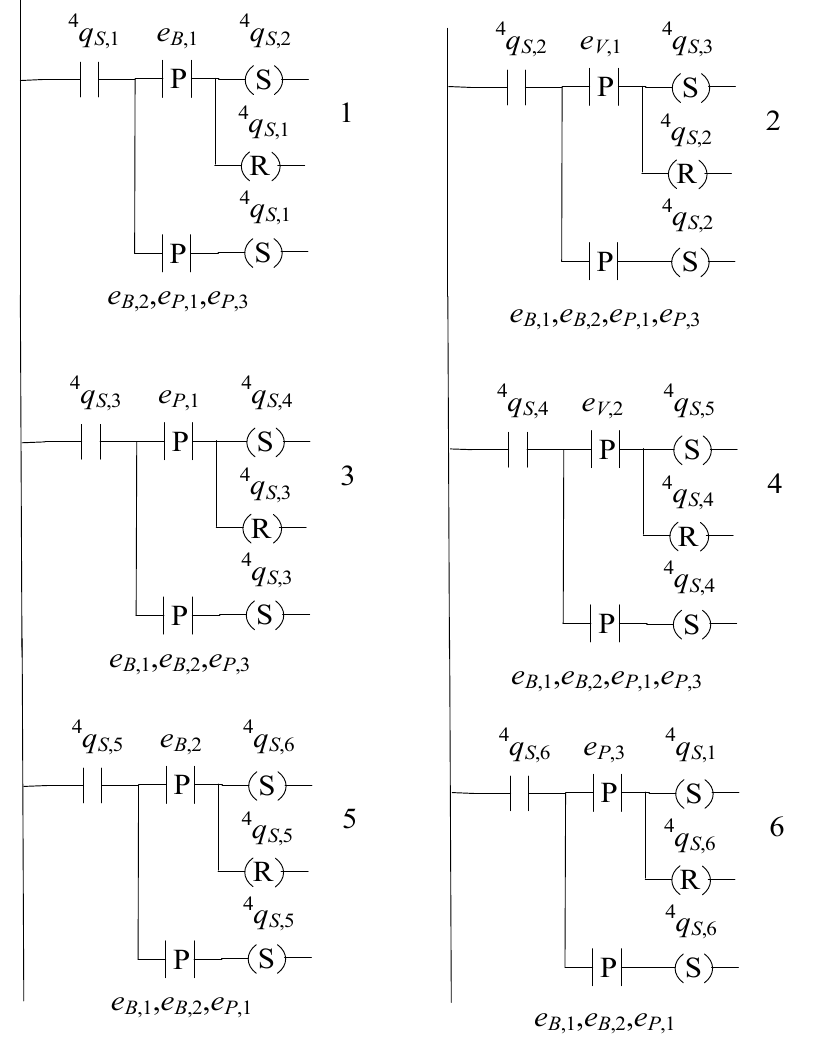
Figure 8. Ladder diagram of 4 S .